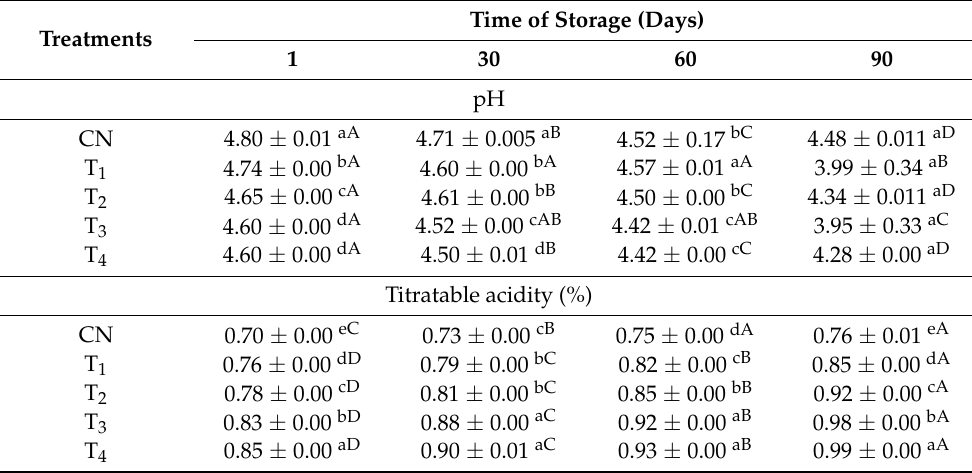
Table 2. Changes in pH and acidity values of different frozen yoghurt affected by adding substantial ratios of JATP during cold